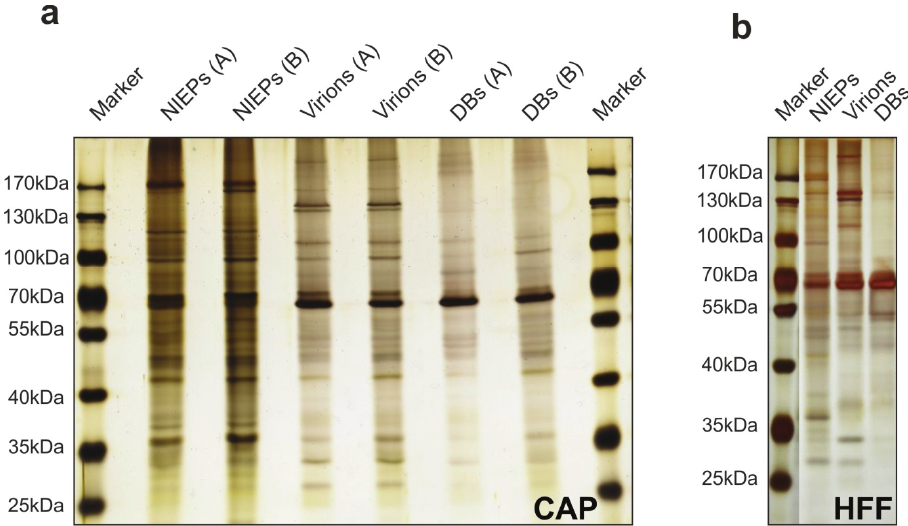
Figure 8. Gel analysis of purified viral particles released into the culture supernatant of adherent CAP cells and HFF (control). CAP adh. and HFF were infected with TowneUL130rep at an m.o.i. of 5 (CAP; A), 2.5 (CAP; B) or l (HFF). Culture supernatants were collected at seven days p.i. and were subjected to gradient centrifugation. Two micrograms of each of the fractions from the gradients were subsequently subjected to PAGE and silver staining. ( a ) NIEPs, Virions, and DBs from the two different purifications; ( b ) NIEPs, Virions, and DBs from the purification of particles from HFF supernatants.